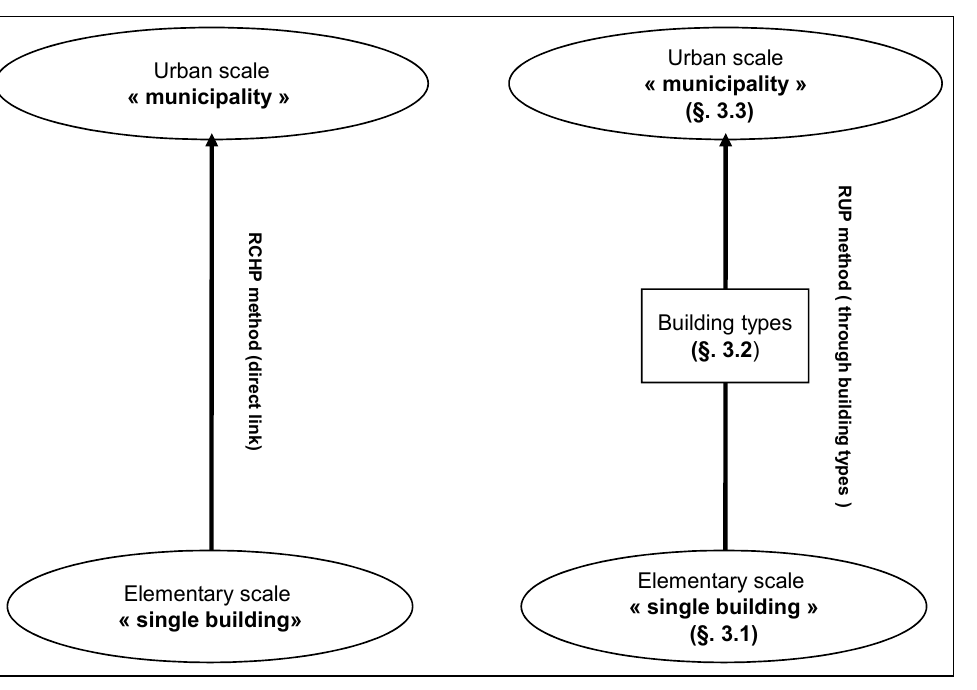
Figure 1. Methodology to link building scale to urban